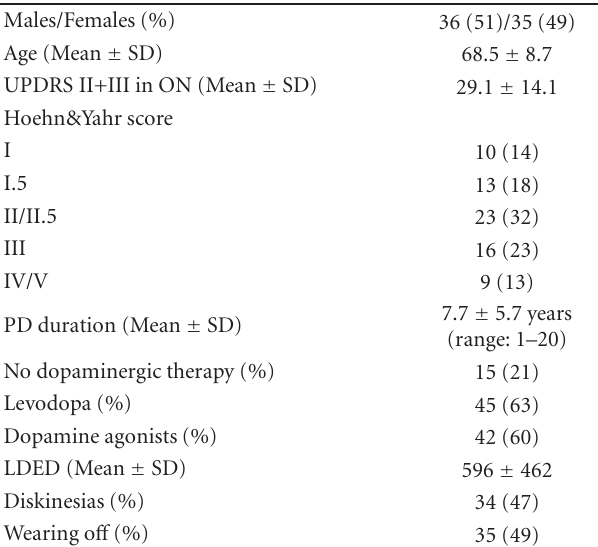
Table 1: Patients